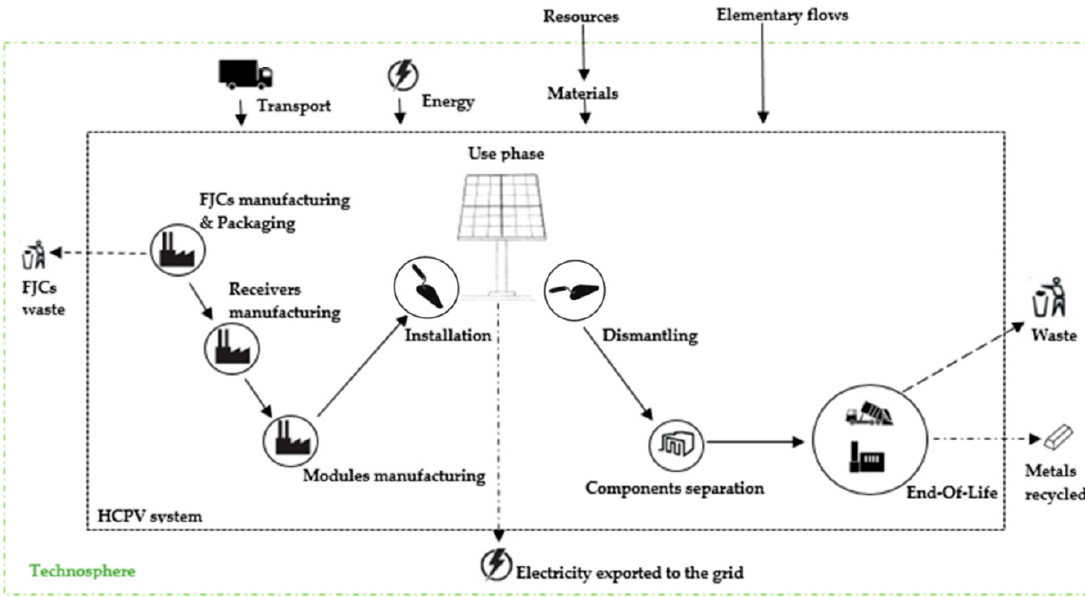
Figure 1. Life cycle of the High Concentration Photovoltaic (HCPV) system. It is a cradle-to-grave approach. Solar cells, HCPV modules, electronic components, and the two-axis tracker manufacturing are taken into account. Transportation is included between extraction and manufacturing, installation, use, dismantling, and end-of-life. A factory is considered for the manufacturing of four-junction cells (FJCs), receivers, and modules. However, only energy inputs (diesel, electricity) are included for dismantling and component separation. The boundary between the system and the ecosphere is represented as the green dashed line, which thus represents the limits of the technosphere. The boundaries between background and foreground system is represented with the dark dashed line.